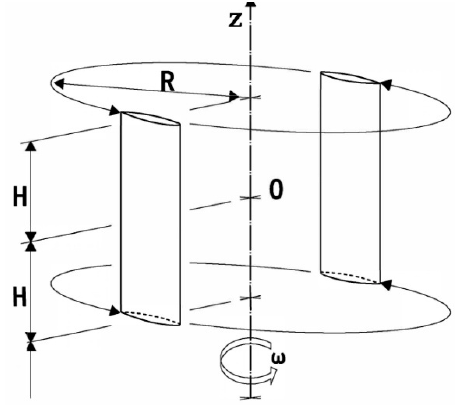
Figure 8. Configuration of an H-type vertical-axis wind turbine (VAWT).